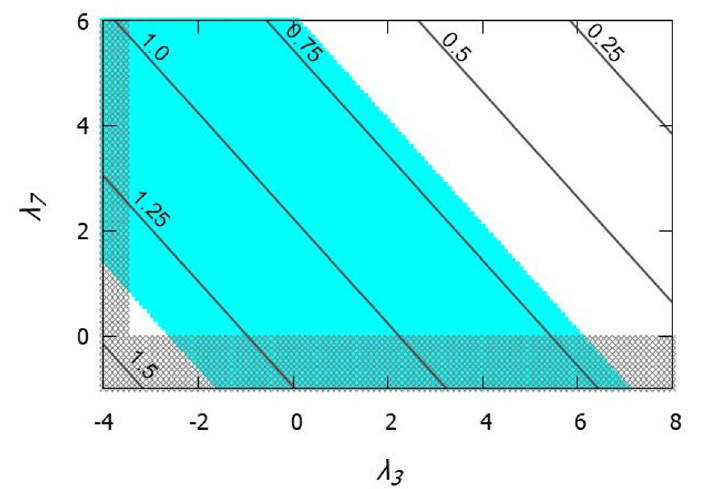
Figure 7 . Contour plots for the scale factor κ µ in the λ 3 - λ 7 plane for M µ = 2 TeV, m m = 600 GeV and θ = π/ 4 . The blue shaded region is allowed by the current measurement of the η ± 2 signal strength for the pp → h → µµ process at LHC at 95% CL while the black shaded region is excluded by the bounds from perturbative unitarity and vacuum